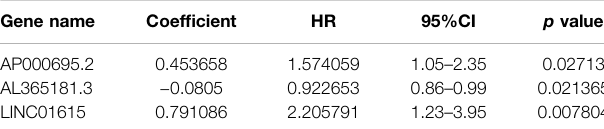
TABLE 2| Threeferroptosis-relatedlncRNAs related